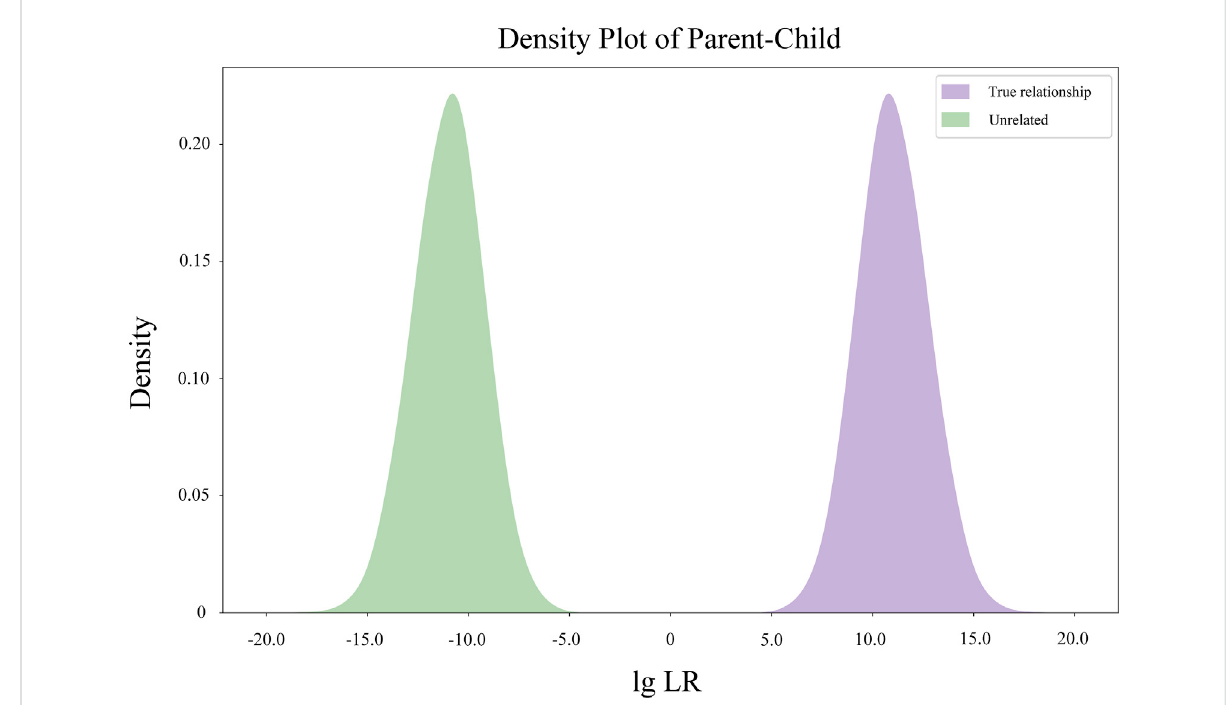
FIGURE 2 Kernel density diagram of Log10 (LR) value distribution of simulated parent-child